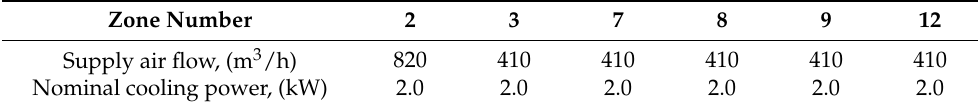
Table 5. Cooling units and air flow.